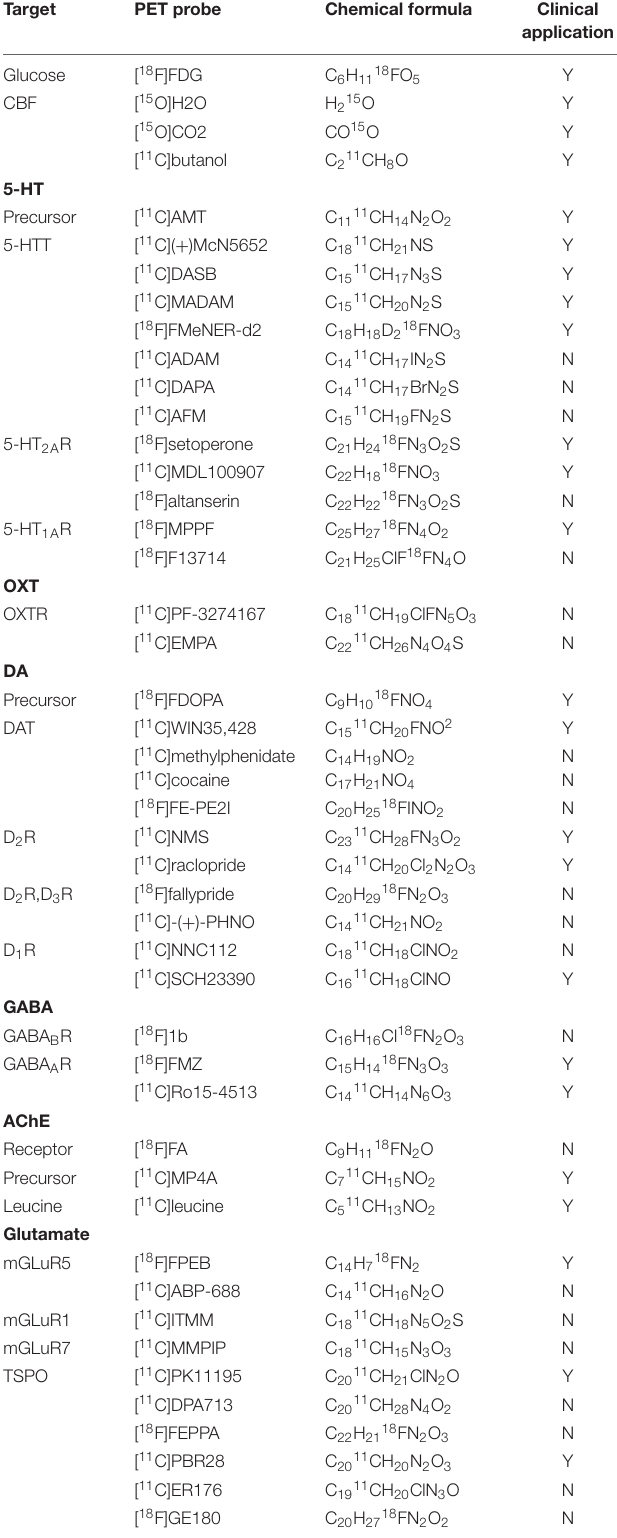
TABLE 1 | Summary of ASD research targets and their corresponding PET probes. Target PET probe Chemical formula Clinical